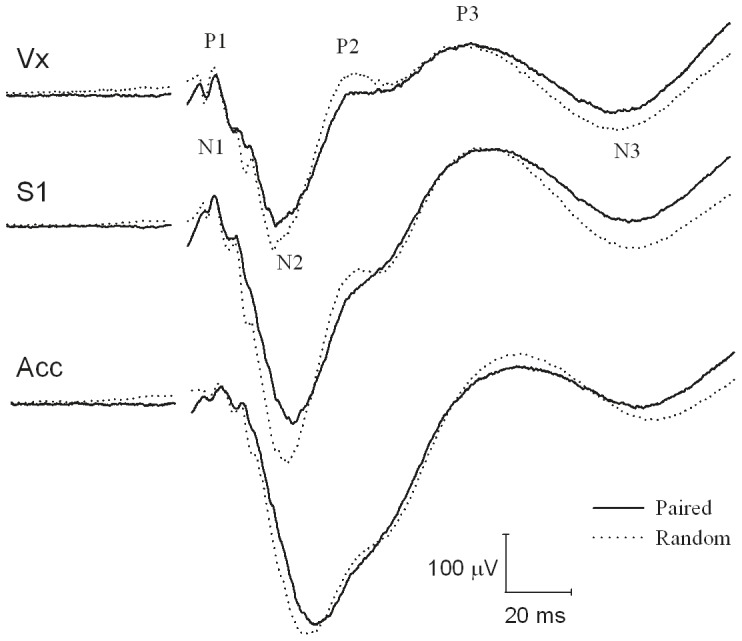
The grand means of the SEP for the different recording sites.Electrodes were implanted epidurally above the vertex (Vx), primary somatosensory cortex (S1) and the anterior cingulate cortex (Acc). The average of the SEP signals obtained during session 2 and 3 for the paired (n = 12) and random group (n = 12). The curve interruption denotes the stimulus onset.